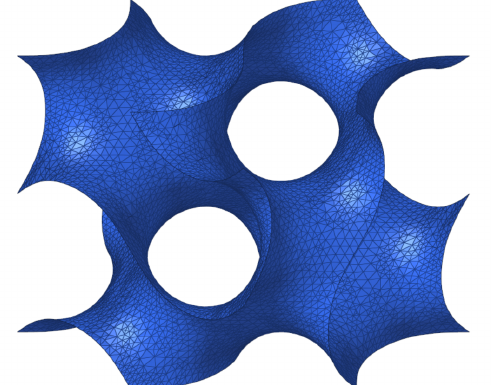
Figure 2. Example of a shell model of the gyroid structure